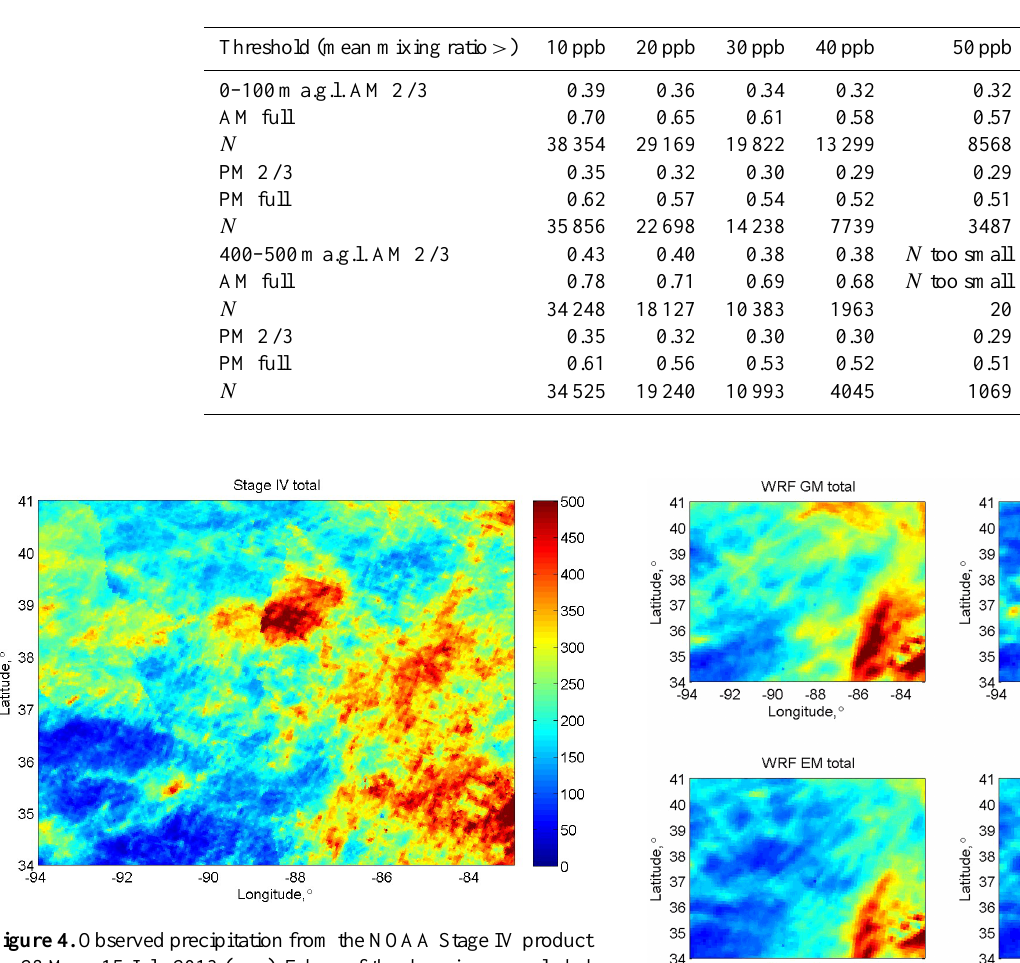
Table 5. Mean normalized CO tracer spreads at two levels of the whole domain with varying mixing ratio thresholds. Number of points is also shown. Grid size is 216 × 236, so maximum possible N = 50976.